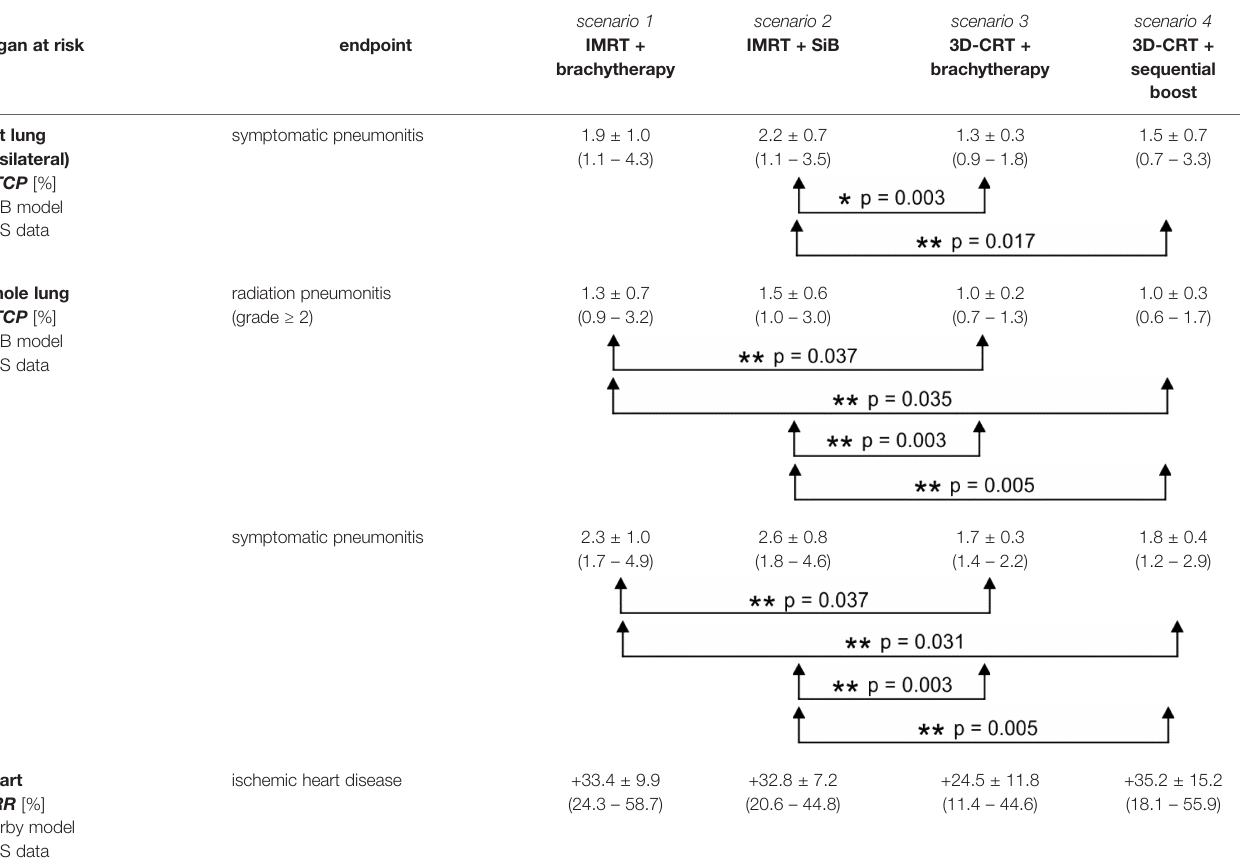
TABLE 5 | Excess relative risk and normal tissue complication probabilities for different organs at risk calculated using the TPS